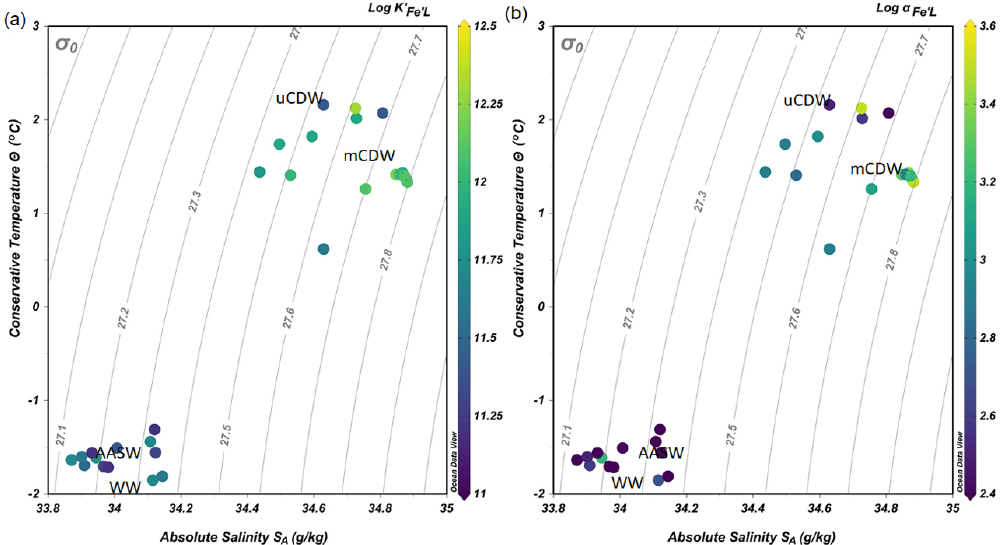
Figure 4. (a) The binding strength, log K cond , and (b) complexation capacity, log α Fe’L , plotted in a diagram of (cid:50) and S A . The color scale Fe (cid:48) L indicates the values of log K cond and log α Fe’L Fe (cid:48) L